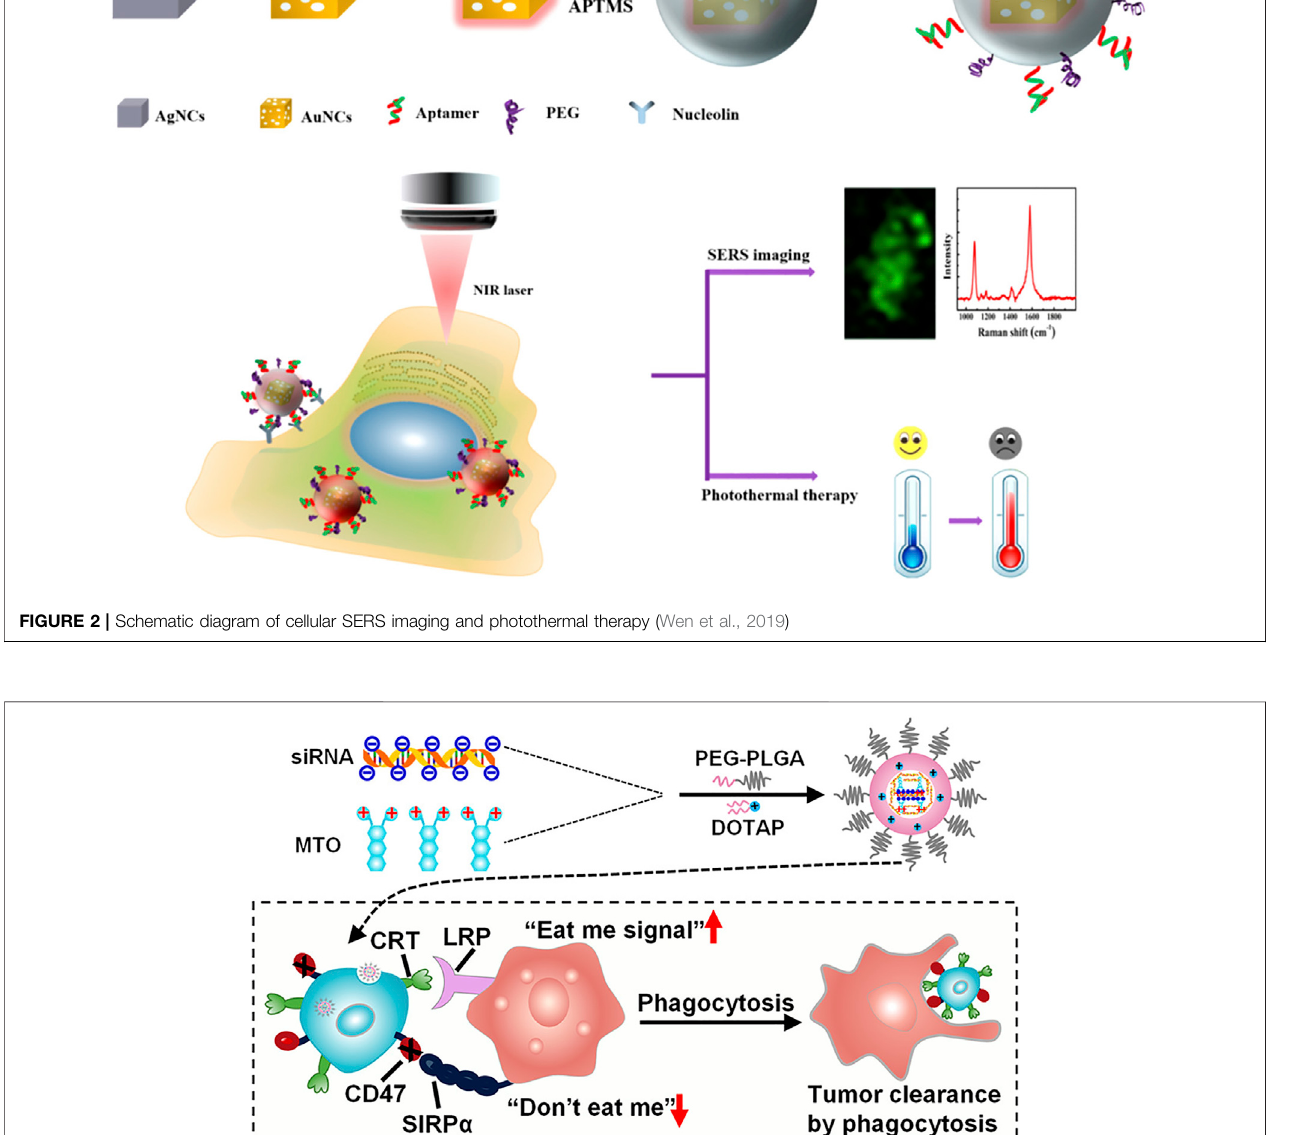
Frontiers in Bioengineering and Biotechnology |